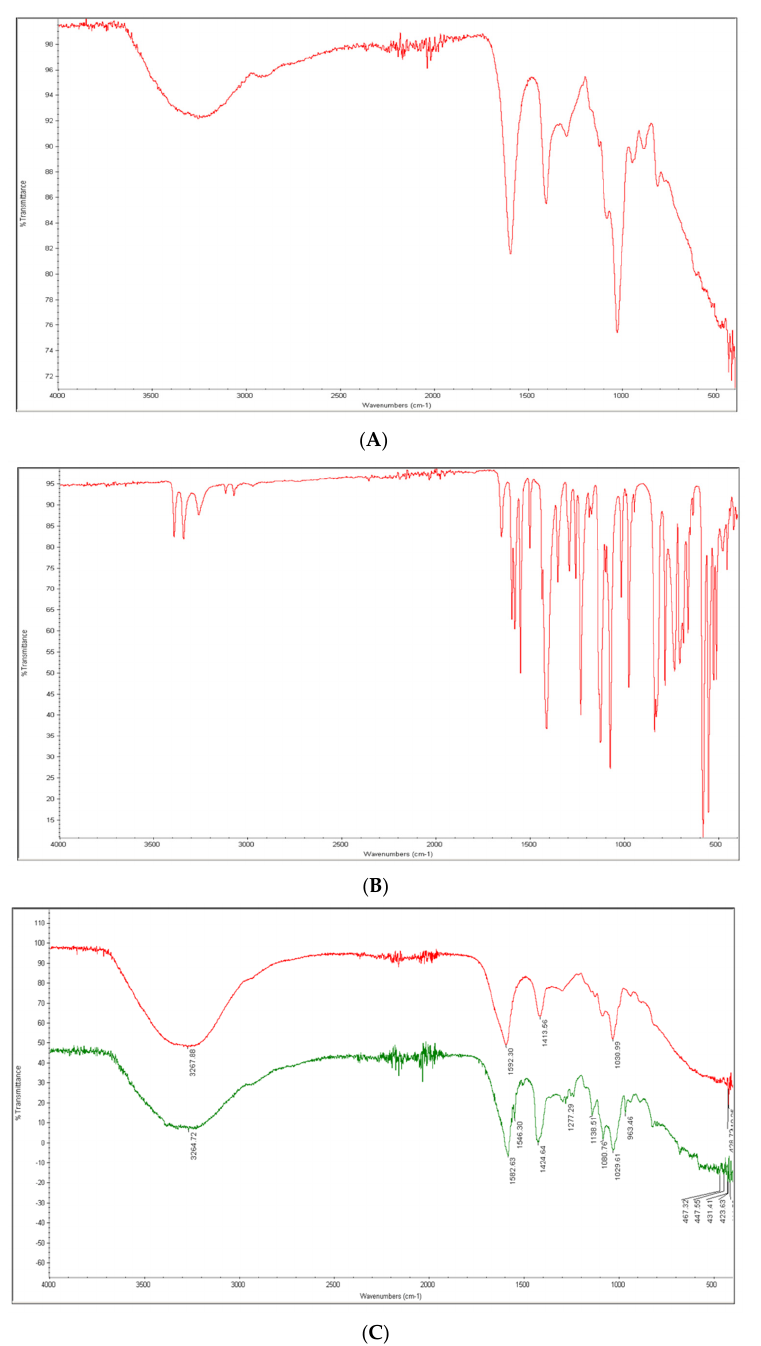
Figure 3. ATR–FTIR spectra. ( A ) sodium alginate; ( B ) silver sulfadiazine powders; ( C ) comparison between the ATR–FTIR spectra of alginate hydrogel (in red) and the alginate SSD-containing hy- drogel (in green).